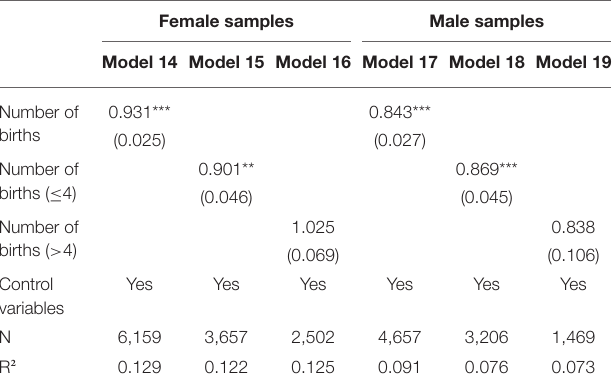
TABLE 8 | Estimates of gender differences in the effects of the number of births on